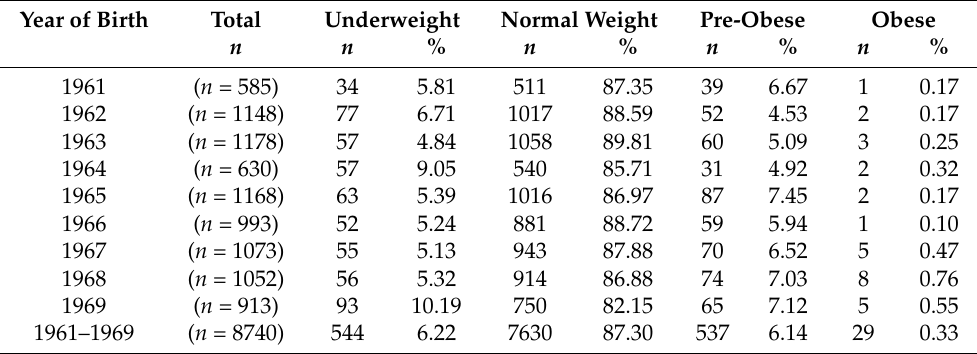
Table 5. The nutrition status by age and total for the young males from the Municipality of Berane enrolled in the study.